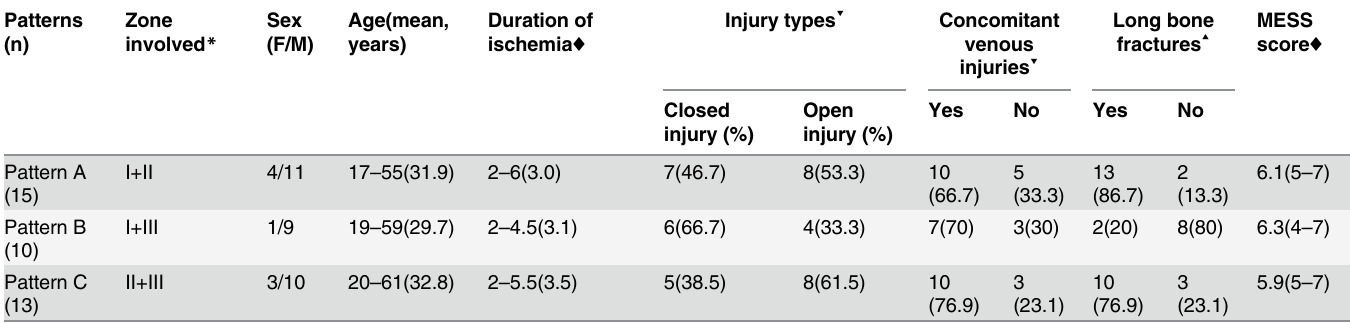
Table 1. Demographic